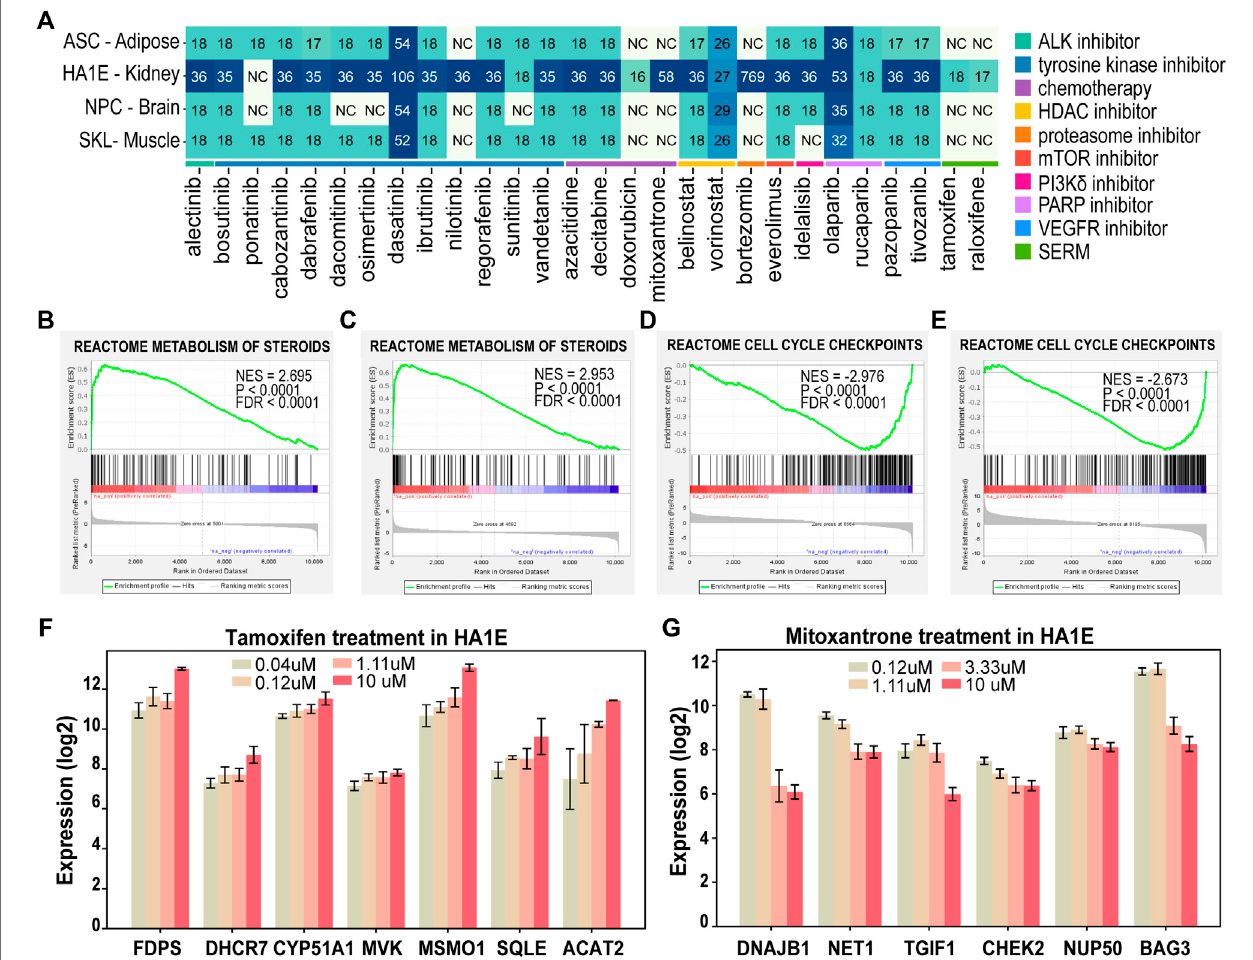
FIGURE5 | Drug-induced transcriptomic alterations recapitulate the mechanism ofaction ofthe treatment in L1000 data. (A) The number ofexpression pro fi les of normal cells treated by the 28 FDA approved in L1000 data. (NC: Not included, SERM: Selective Estrogen Receptor Modulator). (B – E) GSEA analysis of Reactome databasegenesignatures. (F) Genesin “ metabolismofsteroids ” showedincreasedexpressioninHA1E cellsaftertamoxifentreatmentatdifferentdosages. (G) Genesin “ cell cycle checkpoints ” showed decreased expression in HA1E cells after mitoxantrone treatment at different dosages. Data are presented as means ± SE.